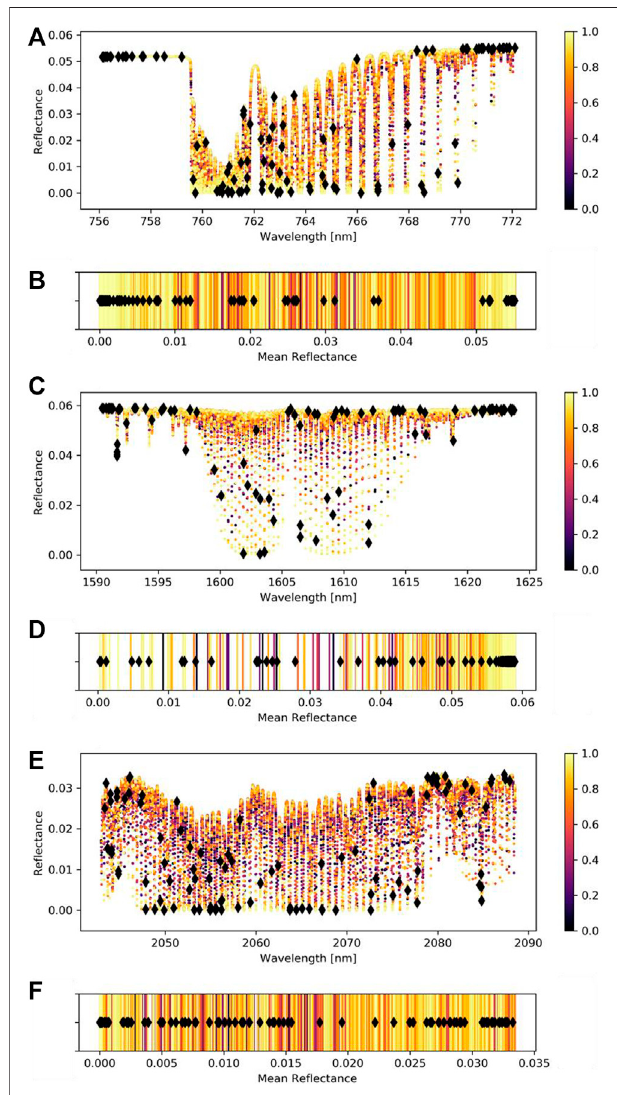
FIGURE 3 | Ordering of information content of each wavelength as determined by the autoencoder for O2A-band (A,B) , WCO2-band (C,D) , and SCO2-band (E,F) . The 100 most important wavelengths are highlighted with blackdiamonds. Themostinformative wavelengths areshown inyellow, the least informative wavelengths in